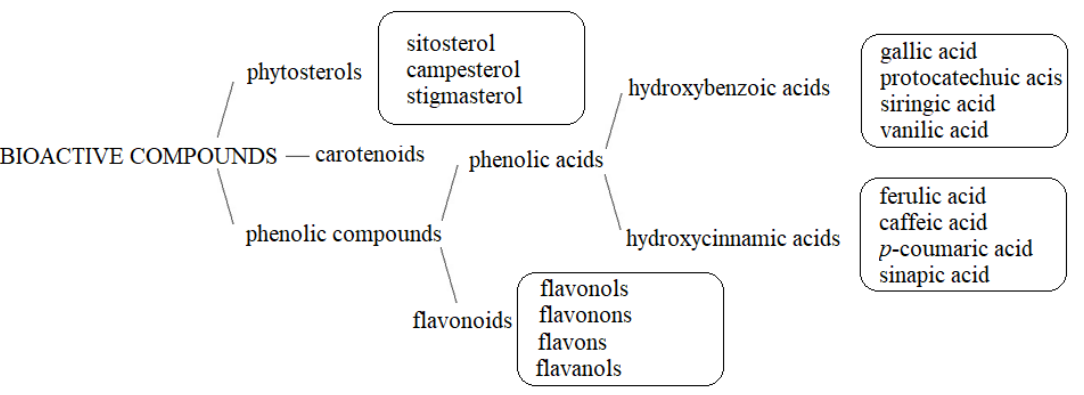
Figure 1. Bioactive compounds in functional food based on sorghum grains. Table 2. Antioxidant activity of bioactive compounds (ABTS • + [ µ molTROLOX/kg]) and the content of free phenolic acids (FPA [mgGAE/100 g]) in selected food products containing sorghum grains.